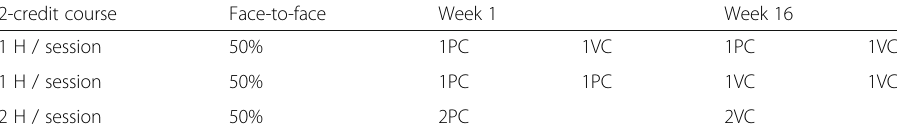
Table 4 Time mix of learning modalities in a 2-credit bLearning course (Source: